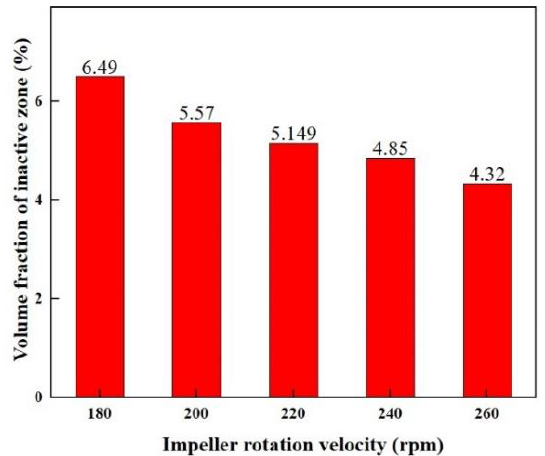
Figure 12. Variation of the volume fraction of the inactive zones at different IRSs.